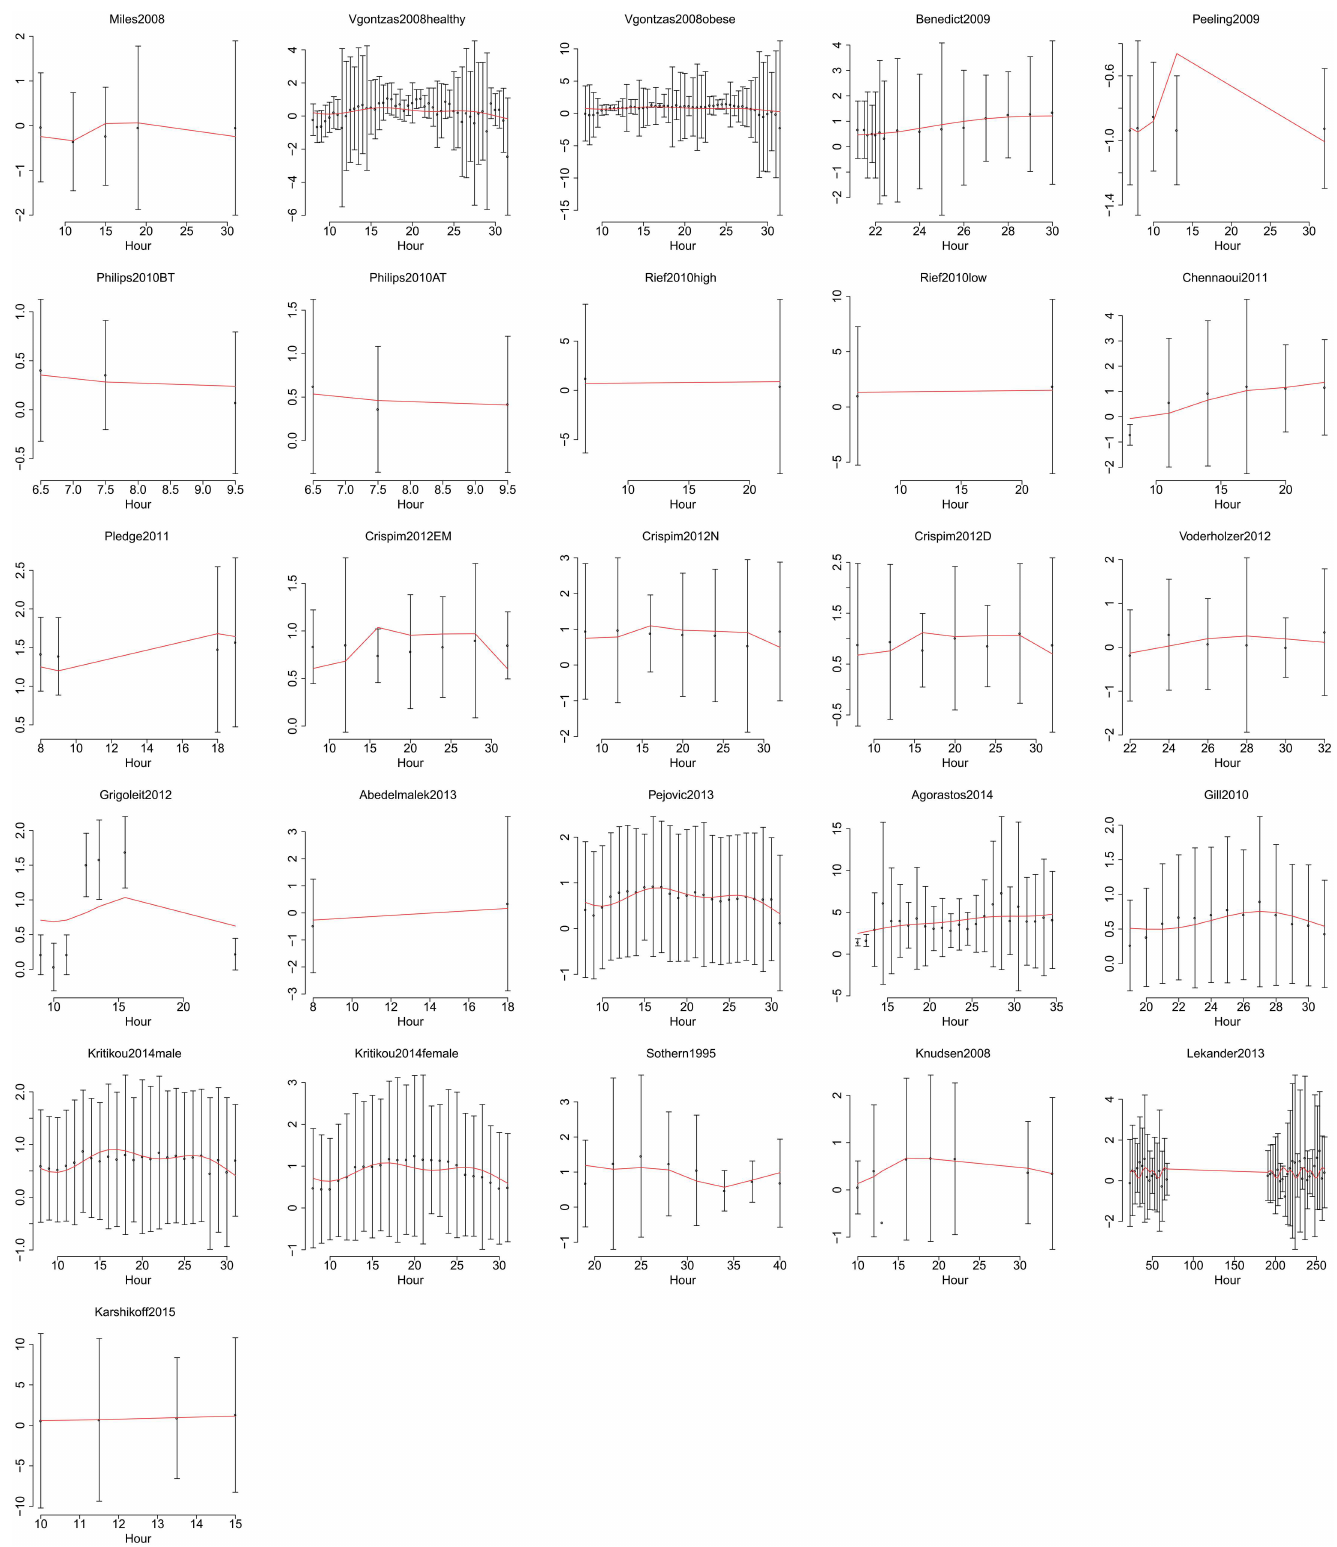
Fig 6. Data and fitted time courses, showing the last 26 out of 56 datasets. Data are shown as estimated from originalpublications, with error bars showingstandard deviations. Y axes show ln IL-6 (pg/ml) throughout. Hours are in chronologicaltime where 1 is 01:00 on the first day. Red lines show predictionsfrom the best-fitting